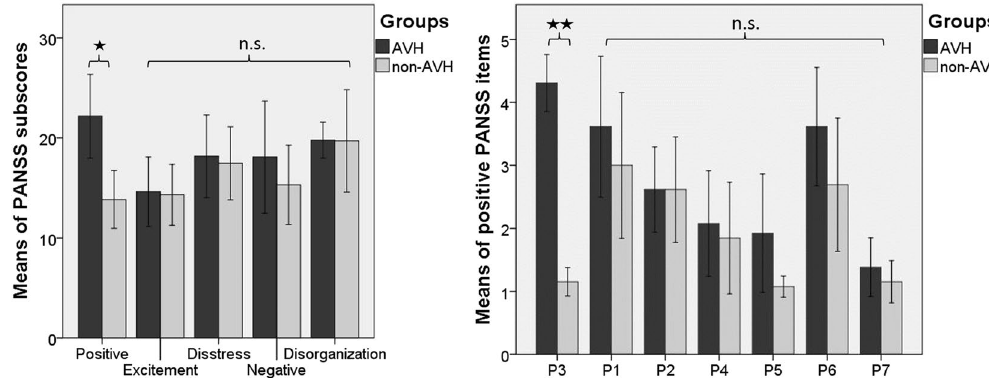
Figure 2. PANSS subscores and positive PANSS items (mean and error bars represent 95% CI). There were significant differences in positive PANSS subscore and the P3 item, which was also used to carefully classify the patients into AVH and non-AVH subgroups ( * p < 0.05; ** p < 0.01). All other PANSS subcores and positive items were not significantly different. AVH, hallucinating patients; non-AVH, non-hallucinating patients; P1, delusion; P2, conceptual disorganisation; P3, hallucination; P4, excitement; P5, grandiosity; P6, suspiciousness/ persecution; P7, hostility.